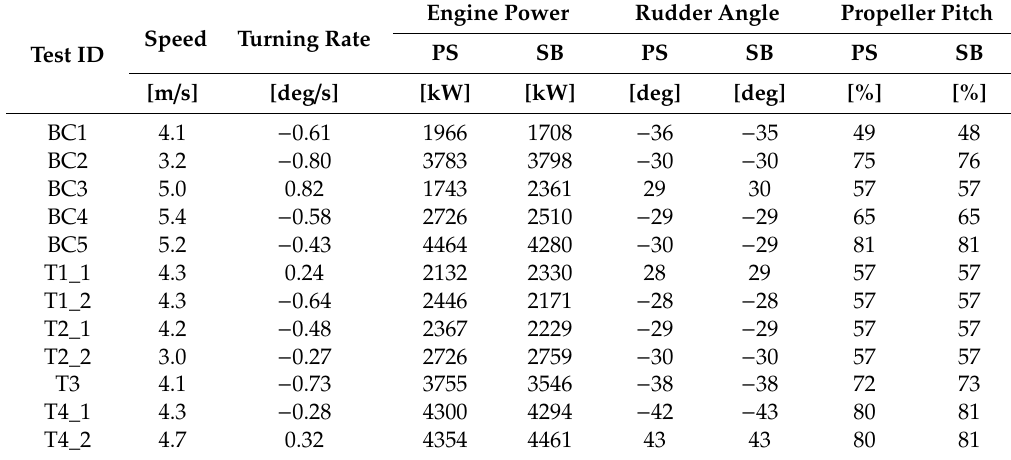
Table 7. Ship navigation and machine control data during the maneuver